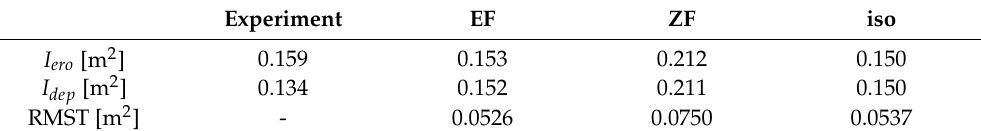
Table 3. Integral transport volumes and RMST values calculated for the experiments and models using Engelund and Fredsoe [37] (EF), Zyserman and Fredsøe [39] (ZF) and isoAdvector with EF (iso). Experiment